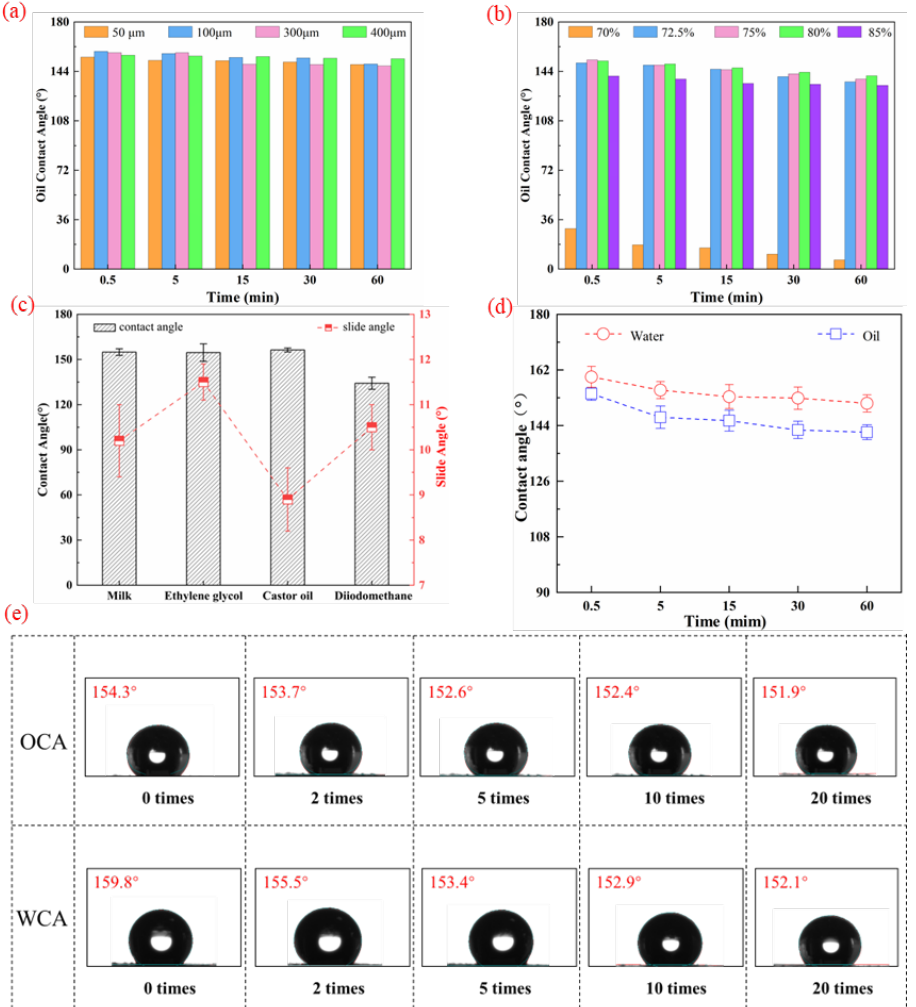
Figure 3. ( a ) The OCAs of the papers with different Fe 3 O 4 NPs concentrations in 1 h. ( b ) The OCAs of the papers with pillar heights in 1 h. ( c ) Apparent contact angle and sliding angle measurements of different liquids on the surfaces. ( d ) The OCAs and WCAs of papers at different times. ( e ) The OCAs of the papers with different abrasion cycles.